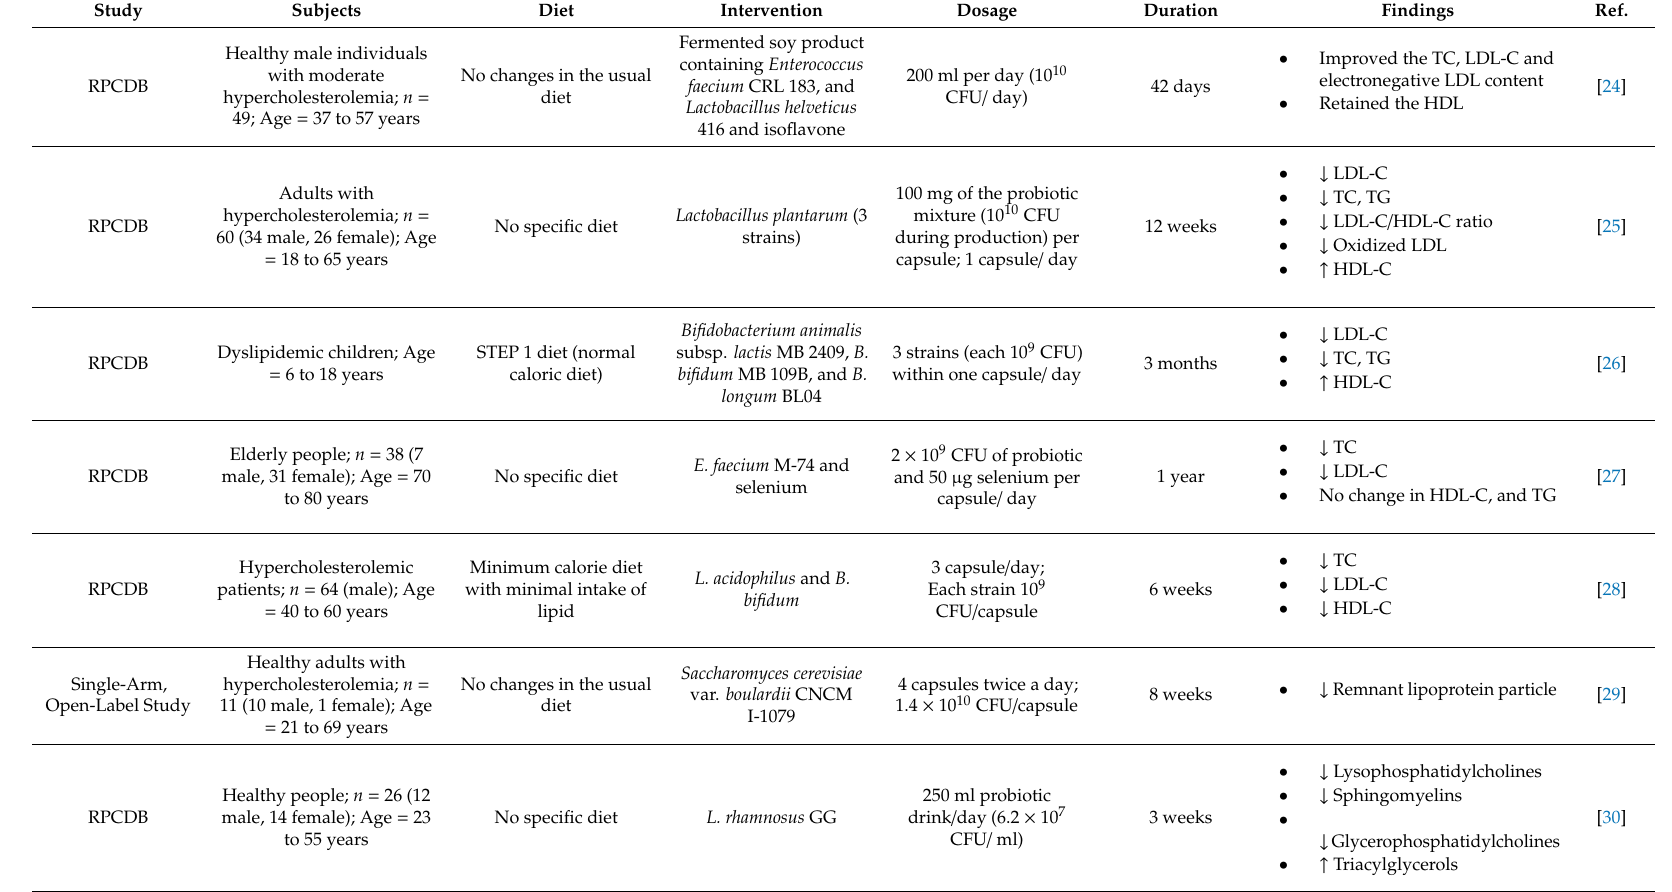
Table 1. Impact of probiotic supplementation on lipid profile of human